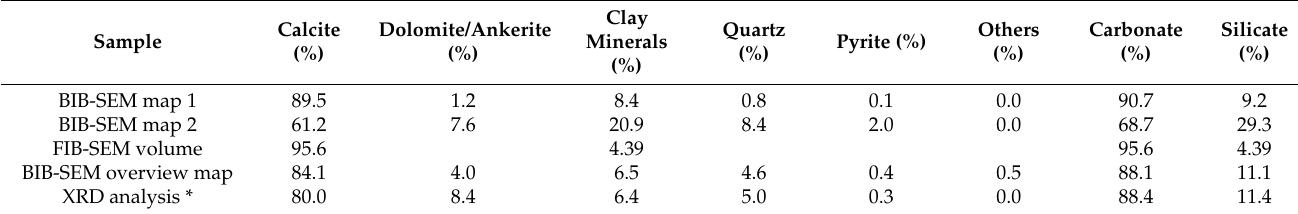
Calcite Dolomite/Ankerite (%) (%)